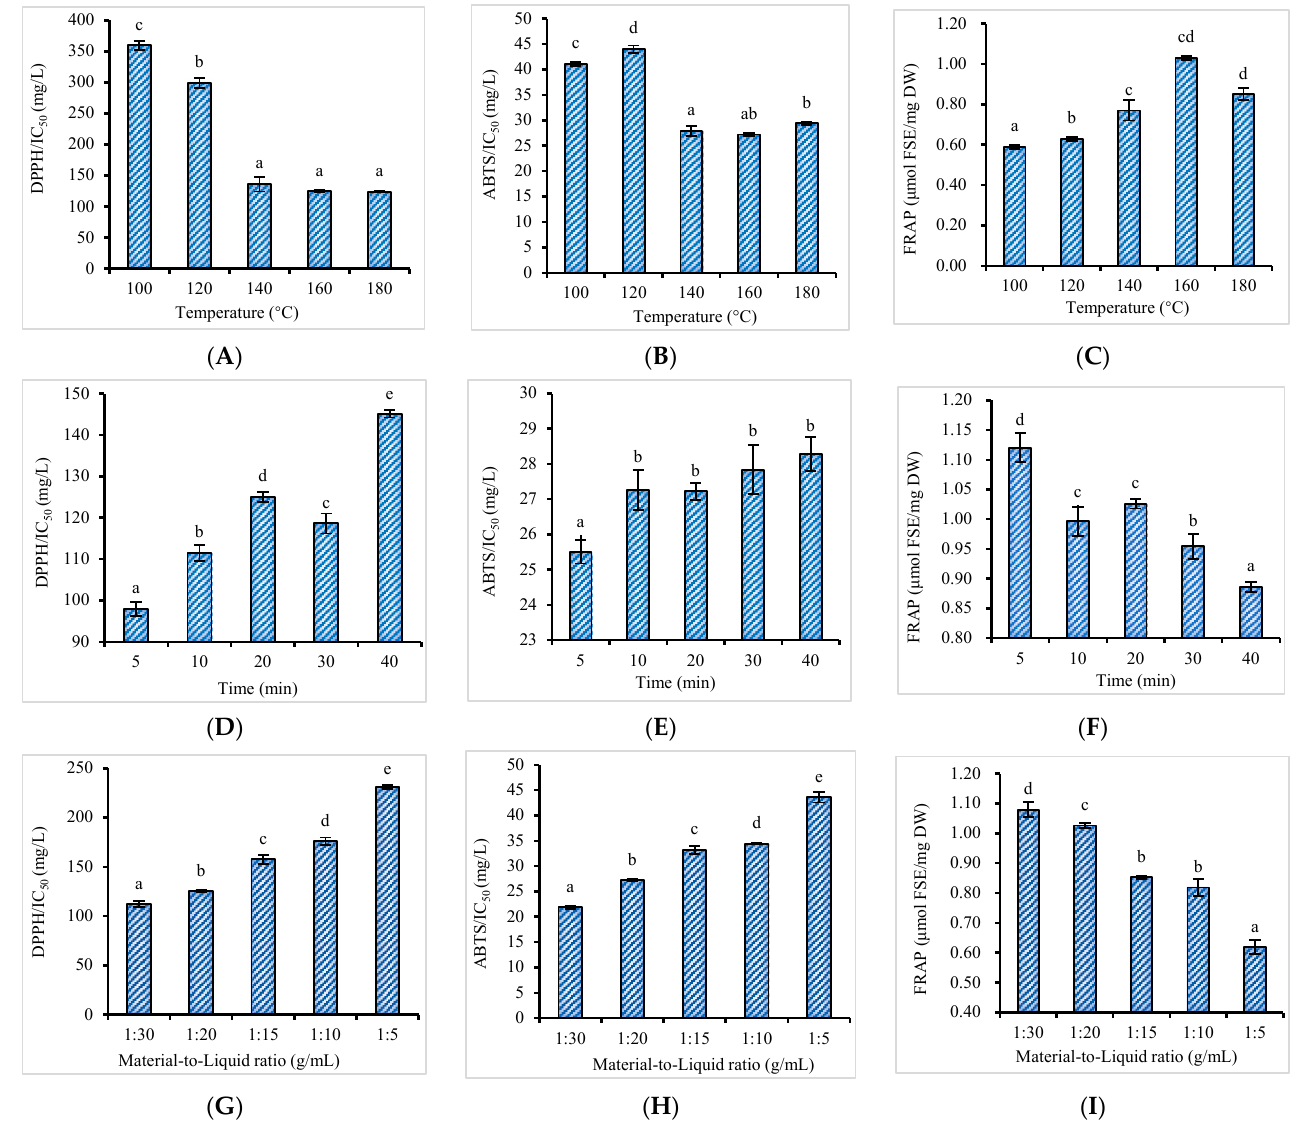
Figure 3. Effect plots of the temperature ( A – C ), extraction time ( D – F ), and material-to-liquid ratio ( H – I ) on the antioxidant capacity measured by 2,2-diphenyl-1-picrylhydrazyl (DPPH), 2,2 ′ -azino-bis (3-ethylbenzothiazoline-6-sulfonic acid) (ABTS), and ferric reducing antioxidant power (FRAP) assays (mean ± SD; n = 3). Values represented with different lowercase letters are statistically significant differences ( p < 0.05). DW: dry weight.